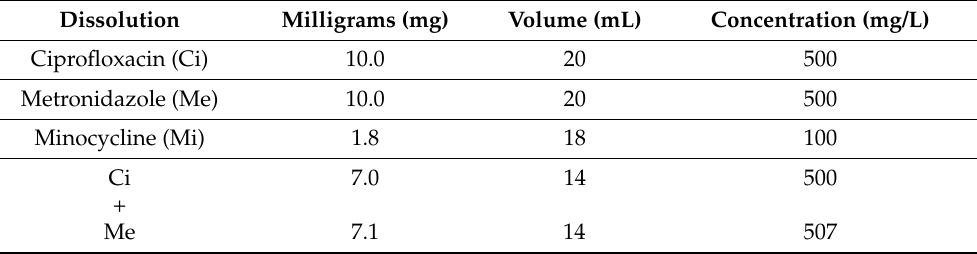
Table 1. Physical characteristics of the used concentrations.